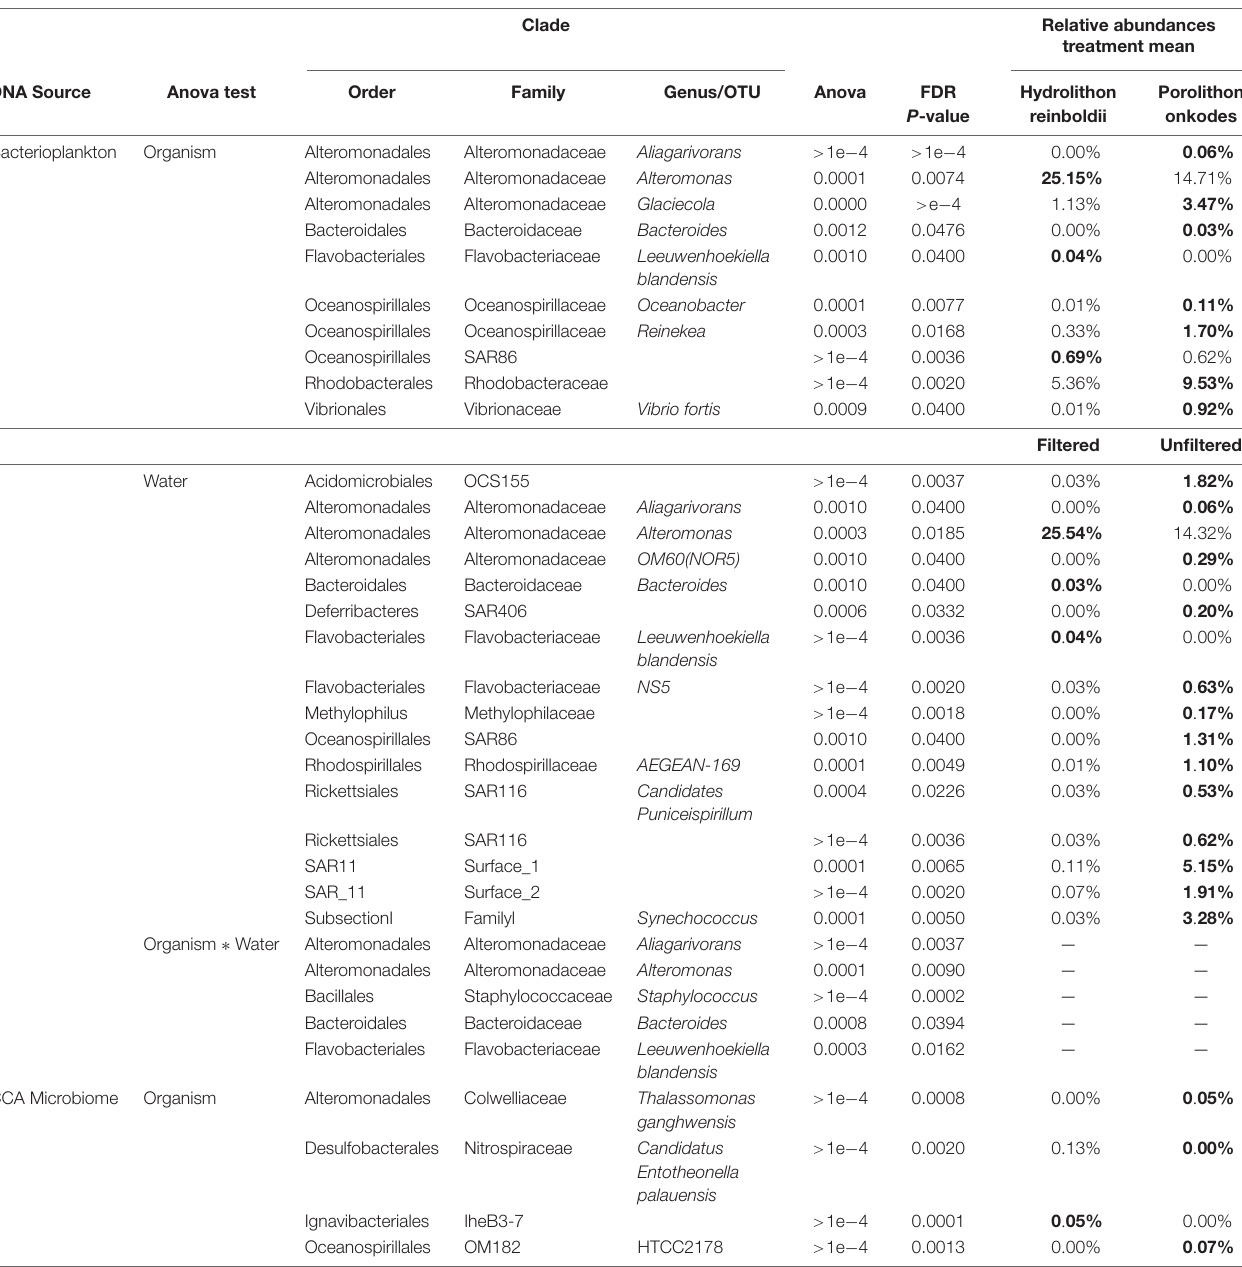
TABLE 1 | OTUs significantly induced by each CCA species and water